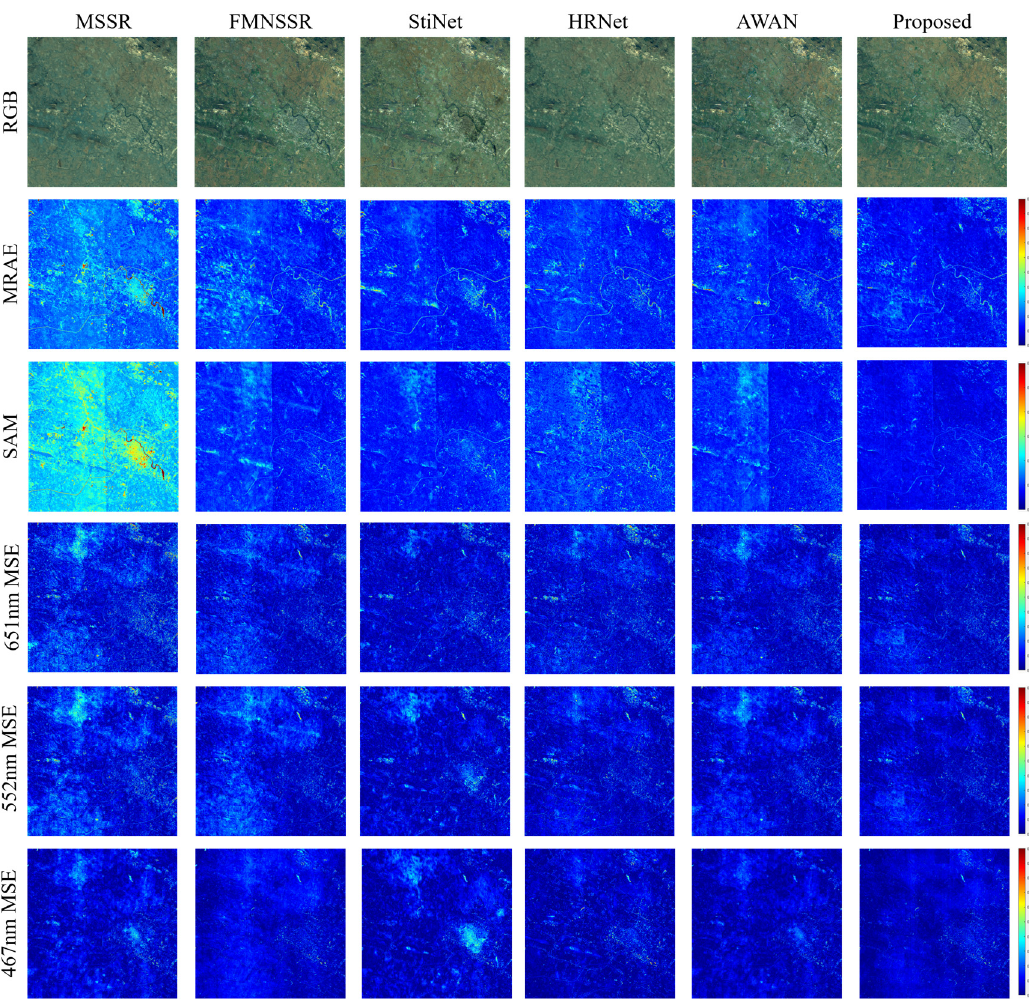
Figure 9. Visual comparison of the results for different methods on the GF5 data.